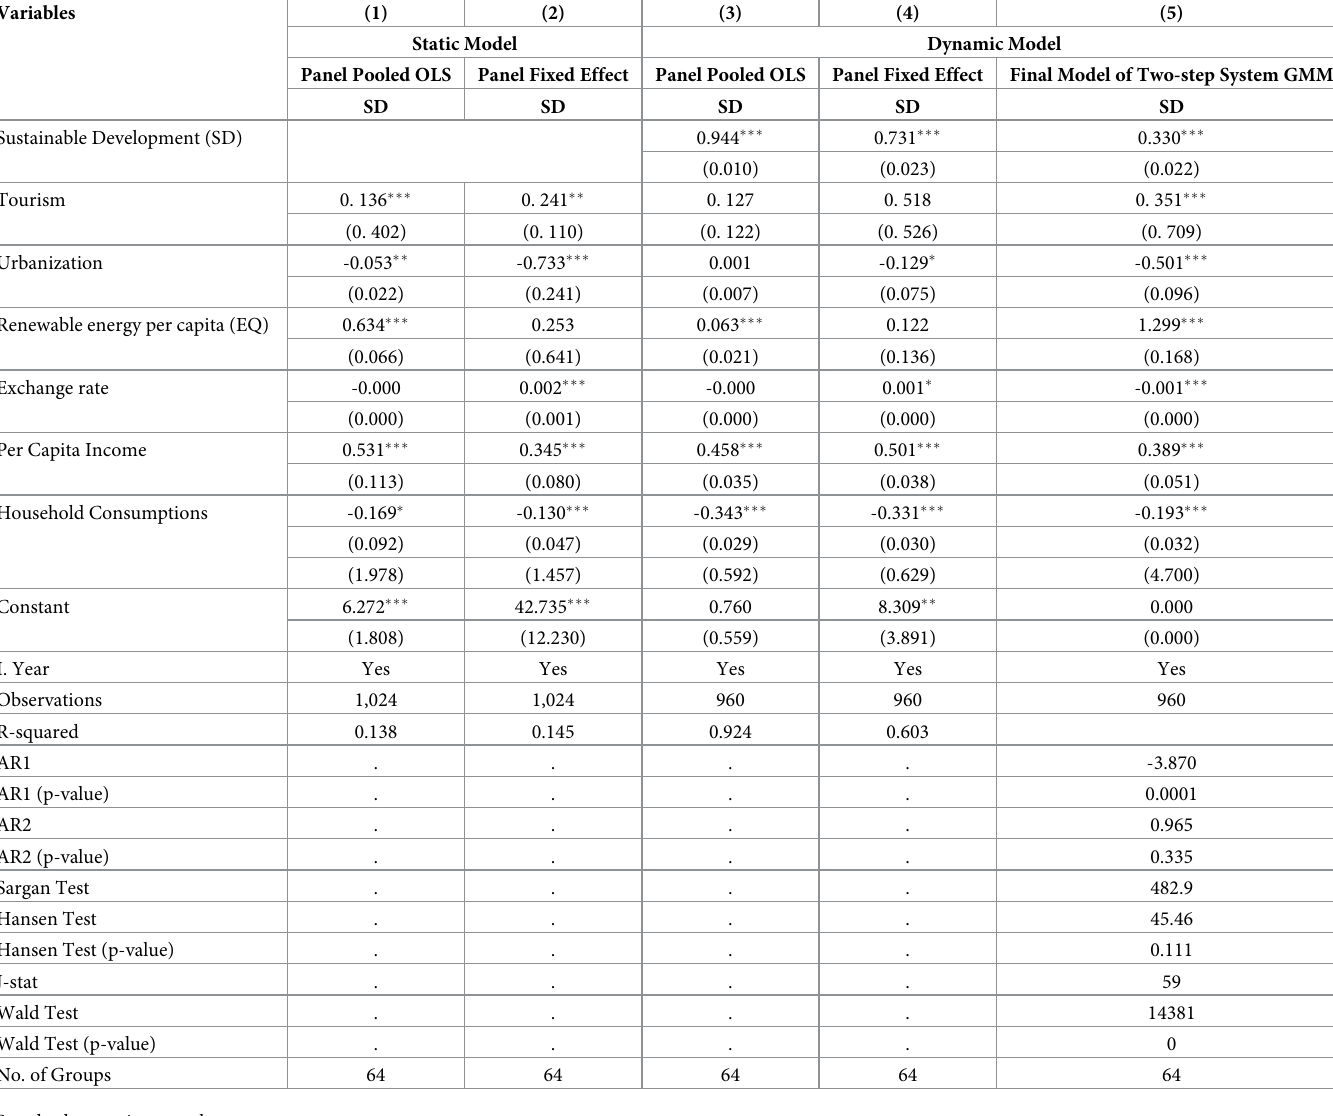
Table 5. Results of factors affecting sustainable development–Direct